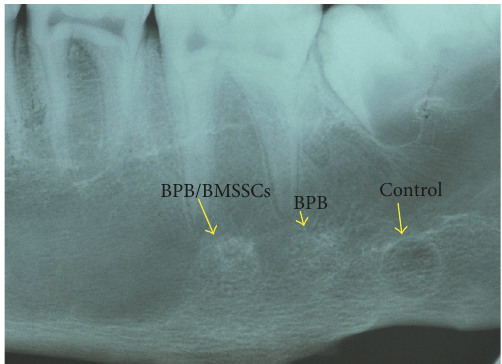
Figure 3: Standard RX 55 × 75mm fi lms have been performed on retrieved mandibulae to fi nd the perfect position and alignment of biomaterial sca ff olds with the bone